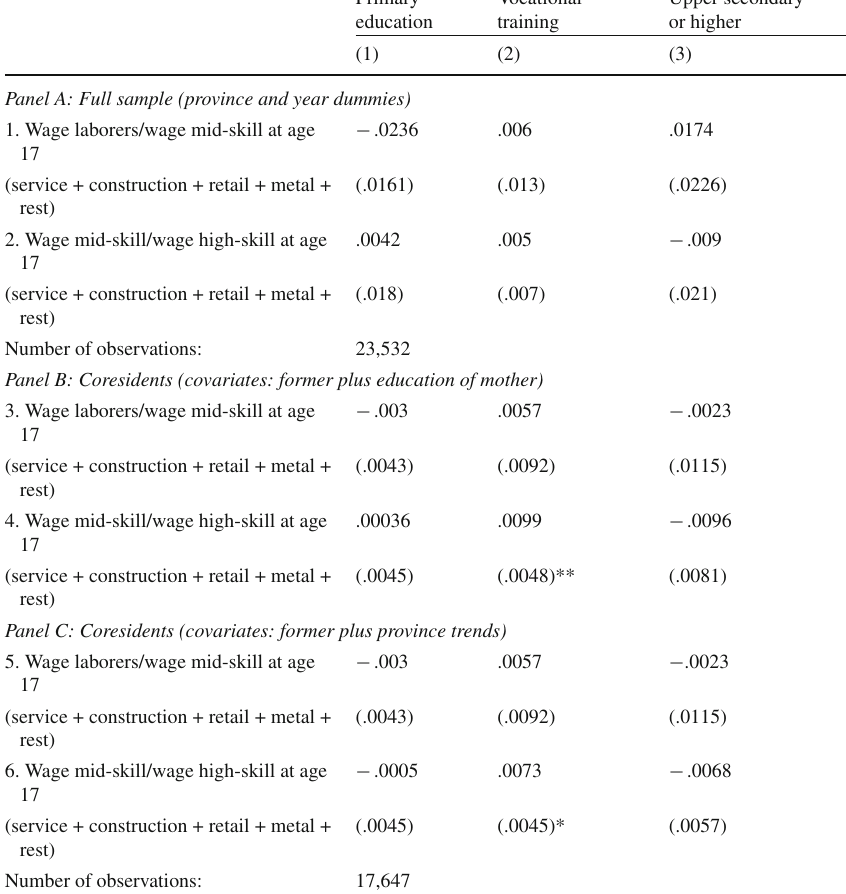
Table 9 The response of schooling attainment of females at age 25 to the return to skill of females at age 17—measured using collective agreements Primary